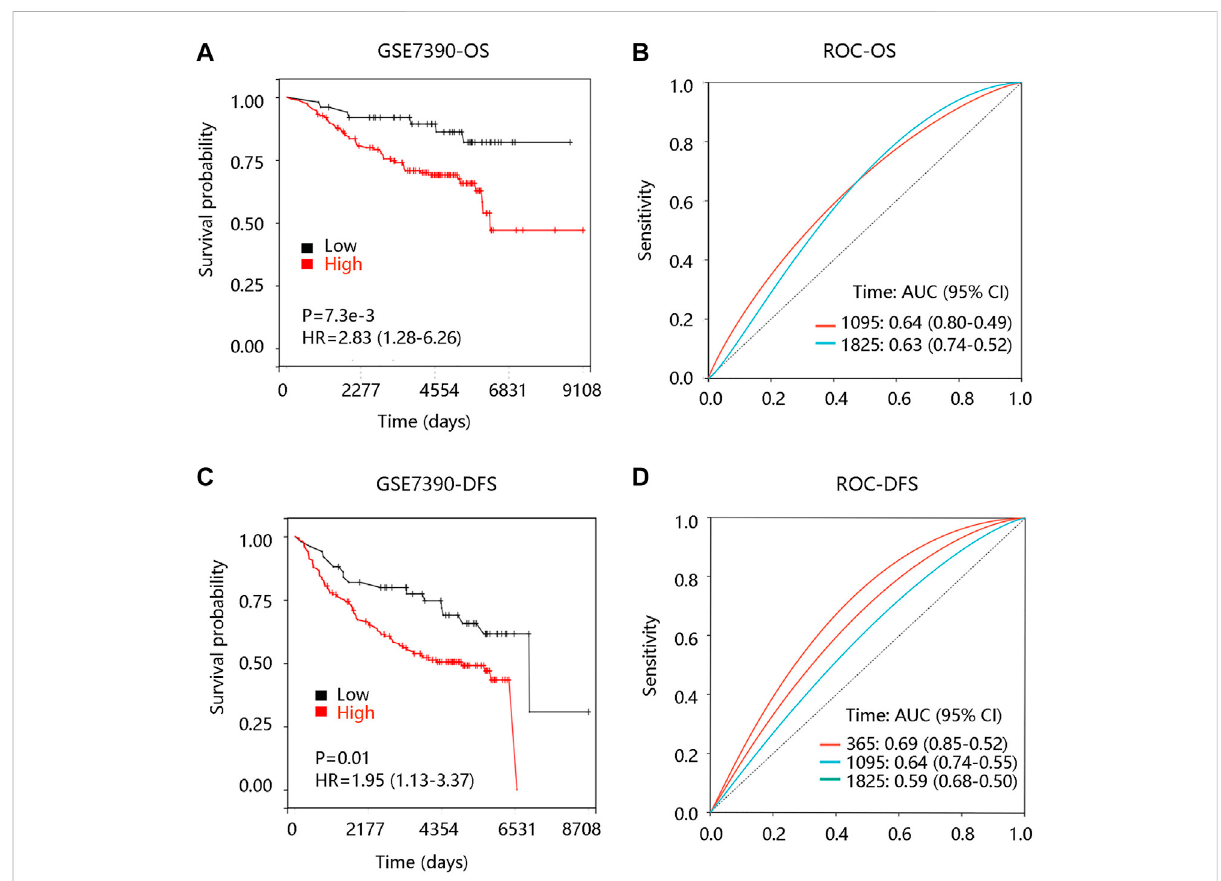
FIGURE 6 PrognosticanalysisofFN1expressioninbreastcancer(BRCA)basedontheGSE7390dataset. (A) HighFN1expressionledtounfavorableoverall